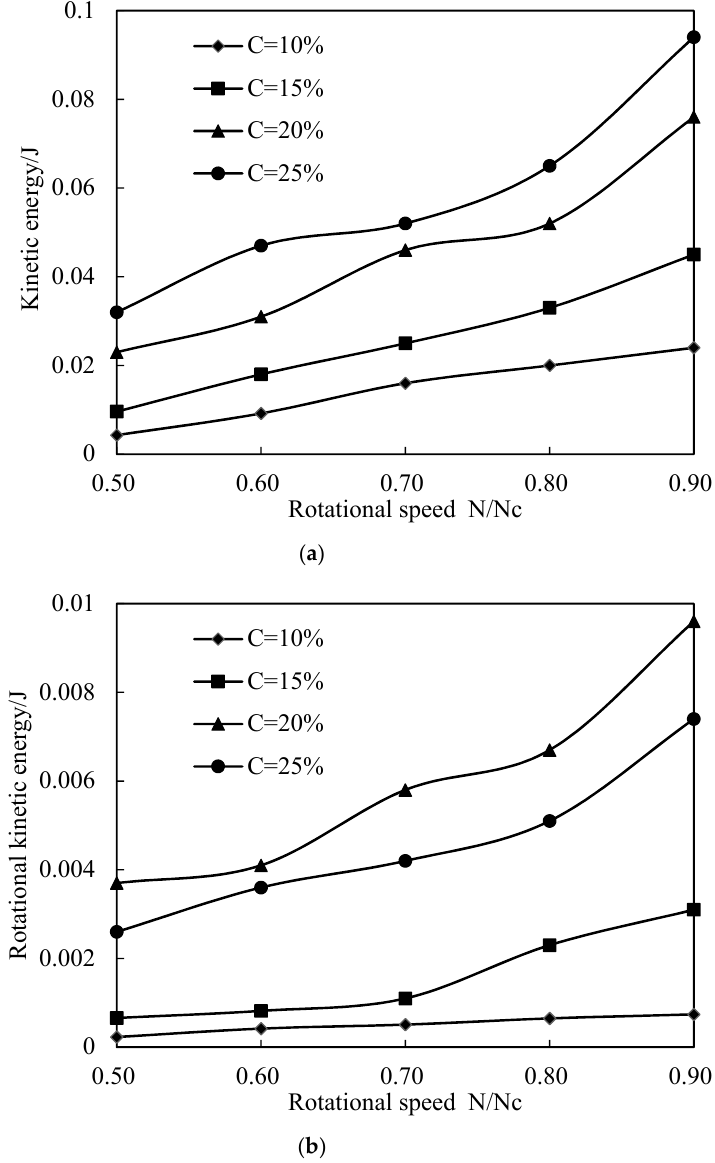
Figure 4. Effect of the rotational speed on ( a ) the kinetic energy and ( b ) rotational energy